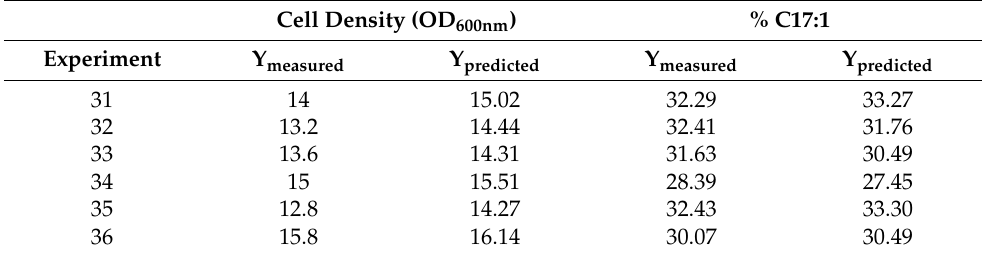
Table 4. Validation of the models using the test